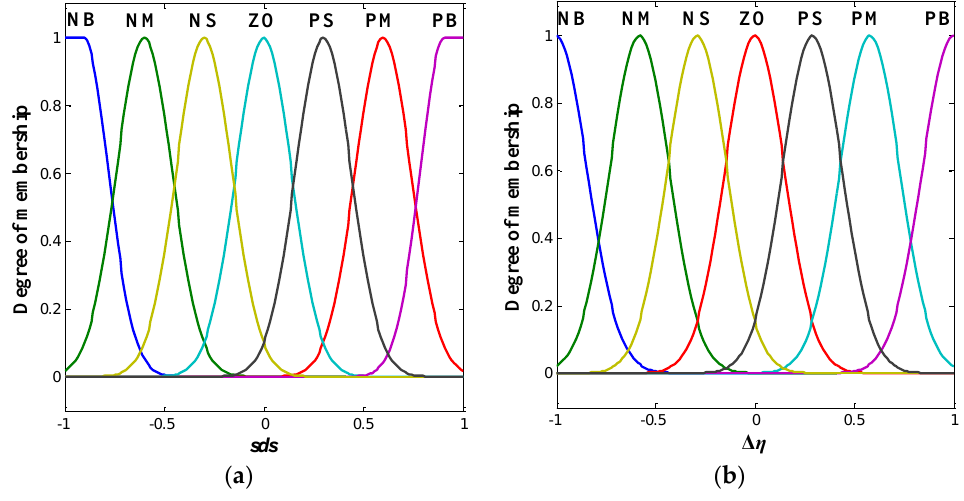
Figure 3. Membership functions for ( a ) the input linguistic variable, and ( b ) the output linguistic variable.